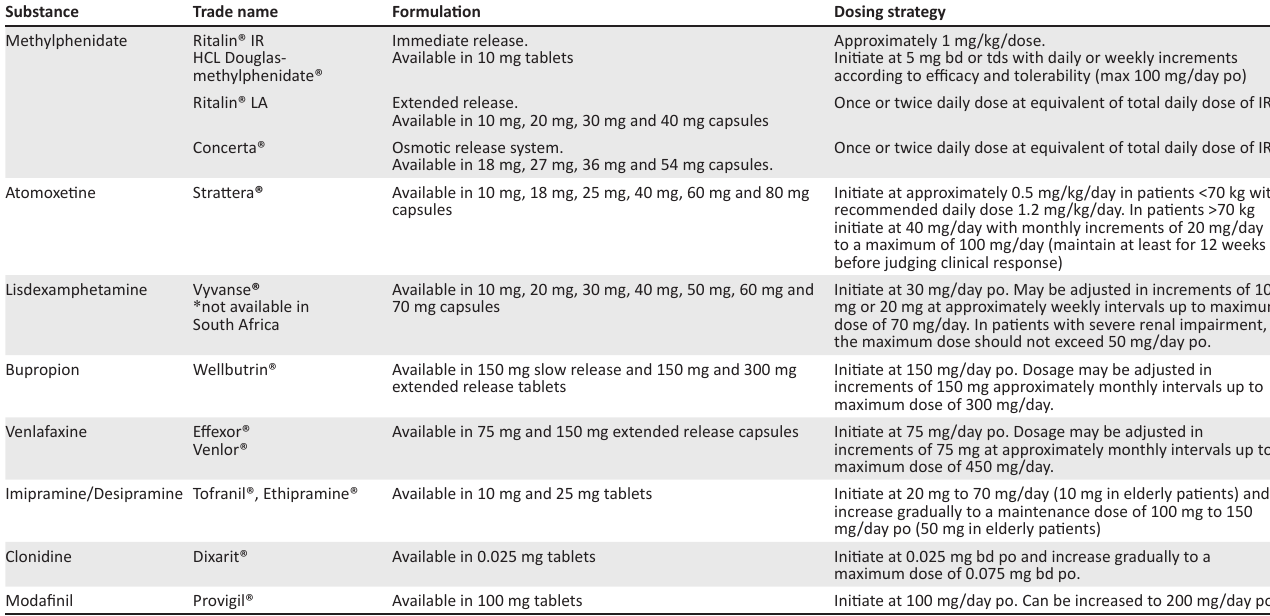
TABLE 2: Medication schedule.